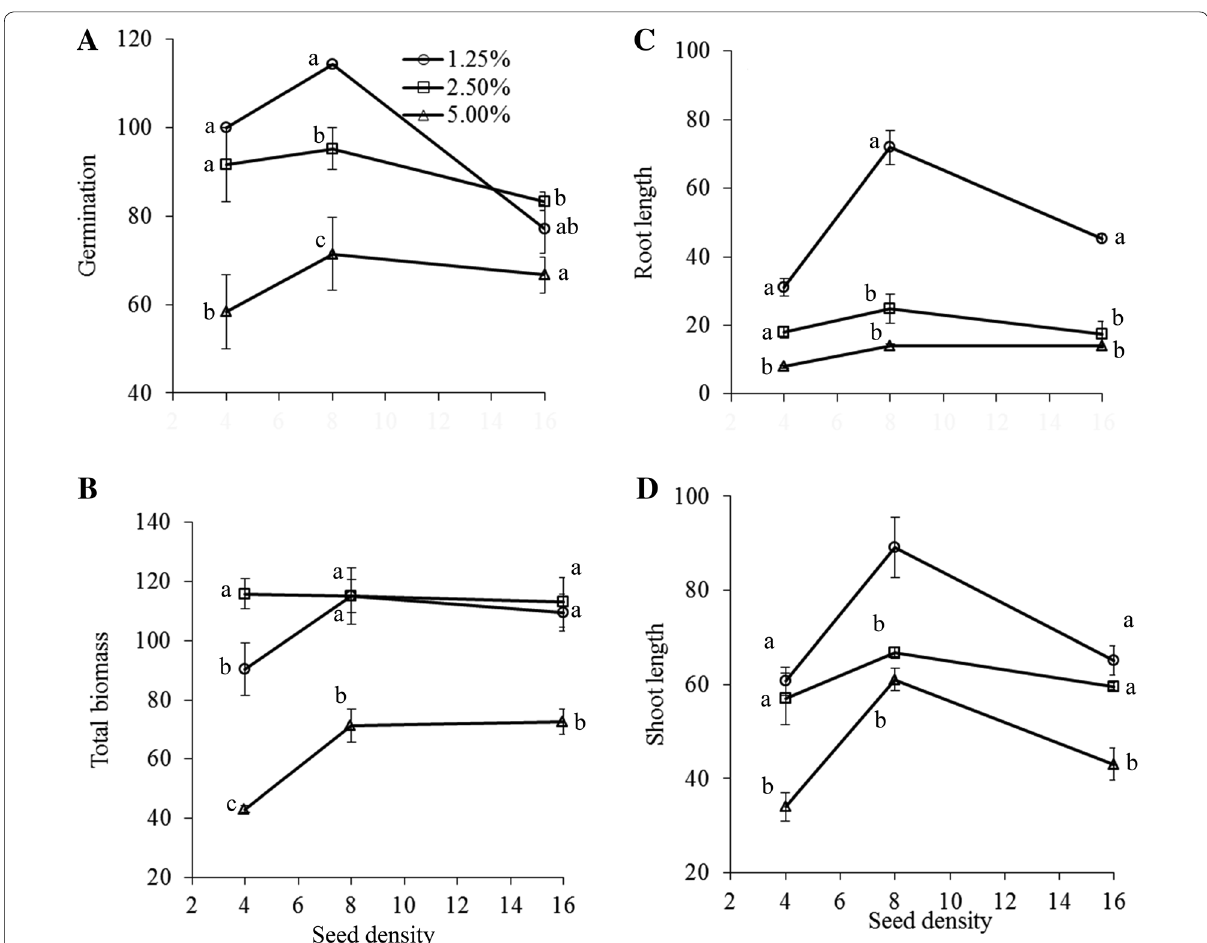
Fig. 4 A Germination percentage, B total mass, C root length, and D shoot length in different concentrations of Phragmites australis litter medi- ated agarose at different seed densities of Lactuca sativa . Values (per plant) are means as % of control treatments at each density ( n 3 ). Letters indicate homogenous subgroups ( P =